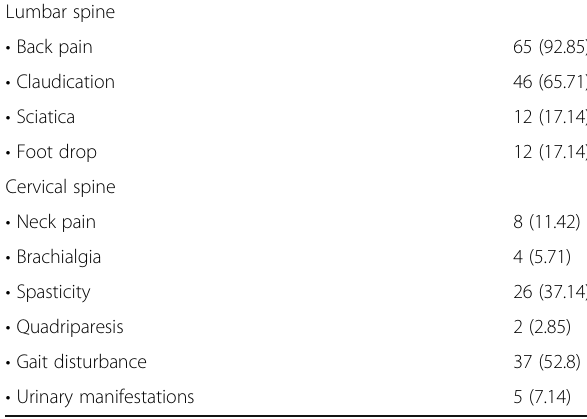
Table 2 Lumbar and cervical spine